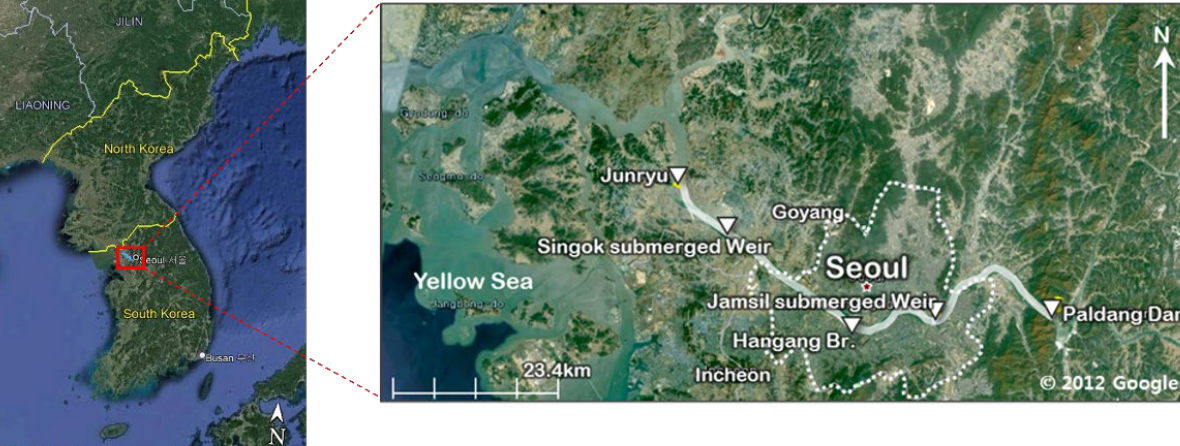
Figure 1. Study area: Han River.